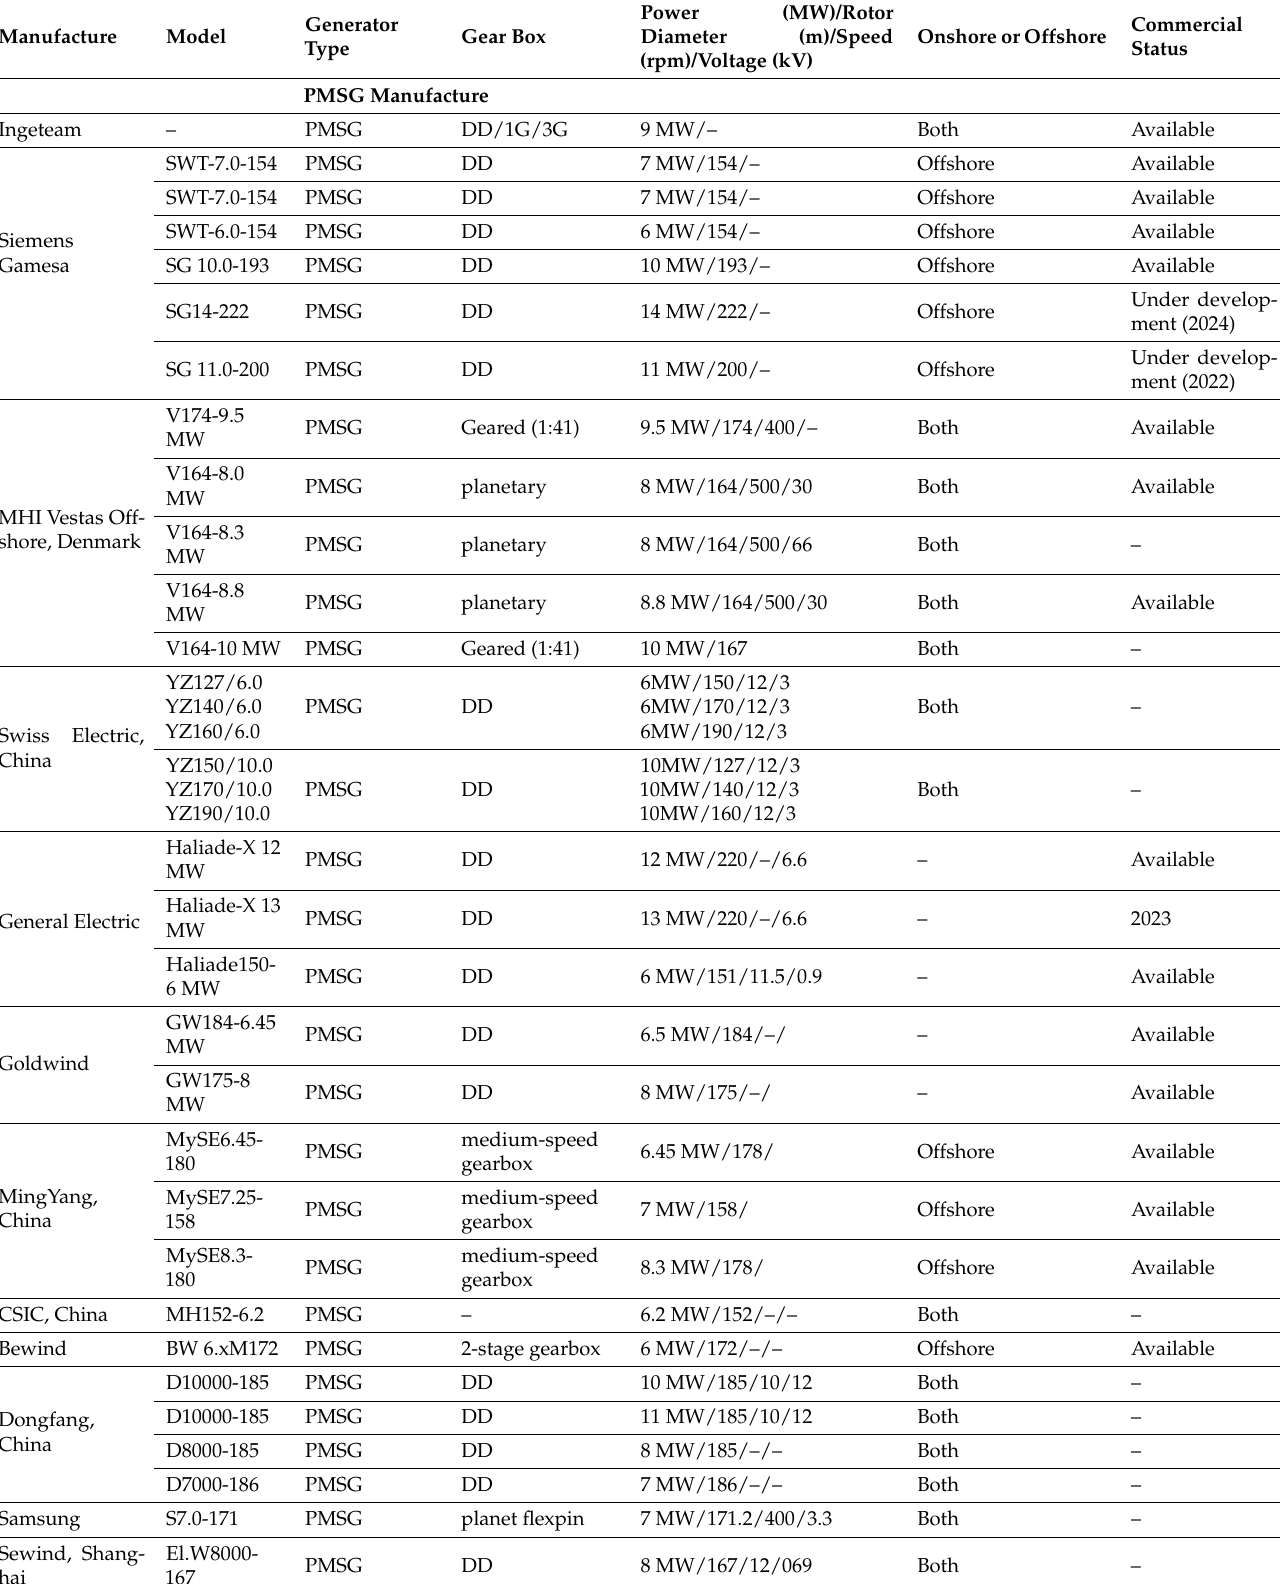
Table 3. PMSG based commercially available high power WT